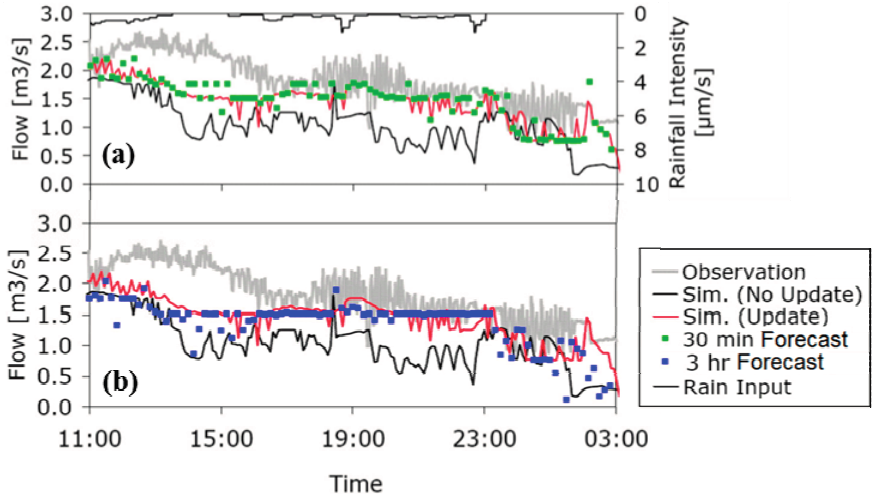
Figure 8. Rainfall (from the top, black curve) and observed flows (grey curves) at the outlet on 25 and 26 December 2009 (part of the hydrograph shown in Figure 7), along with the simulated flow with (red curve, Update) and without (black curves, No Update) updating. The green ( a ) and blue ( b ) squares represent the 30 min and 3 h forecast time series, respectively. See Figure 2 for further